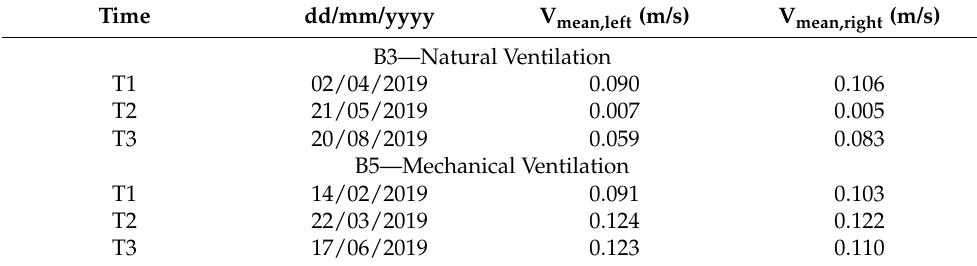
Table 7. Indoor mean air velocity magnitude (V) obtained from the CFD simulations at a level of 0.50 m from the pavement, for the pens on the left and on the right of the central corridor, for buildings W3 and